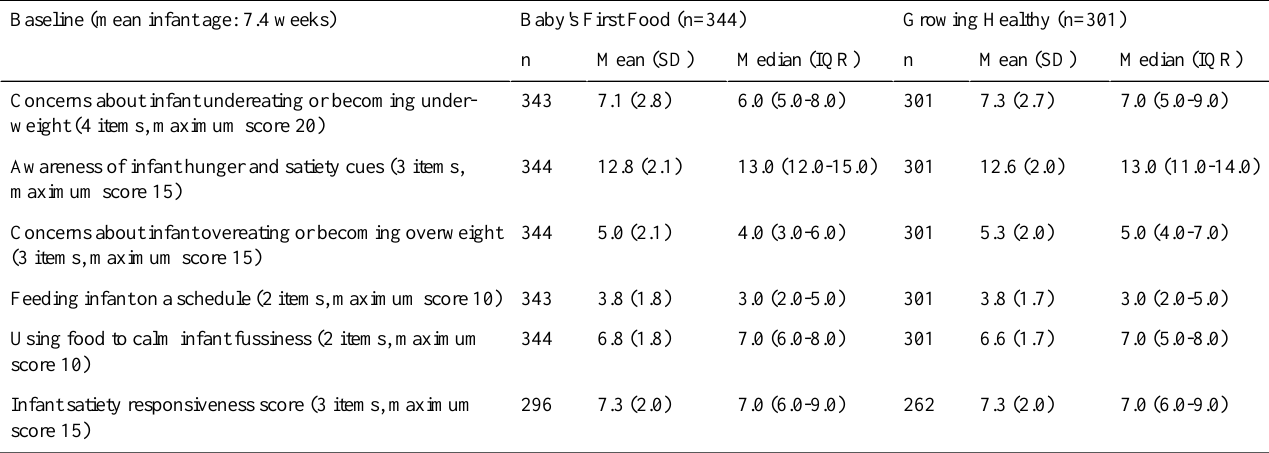
Table 2. Baseline parental feeding practice and beliefs (Infant Feeding Questionnaire) and infant satiety responsiveness (Baby Eating Behaviour Questionnaire) in the Baby's First Food and Growing Healthy samples. IQR: interquartile range.